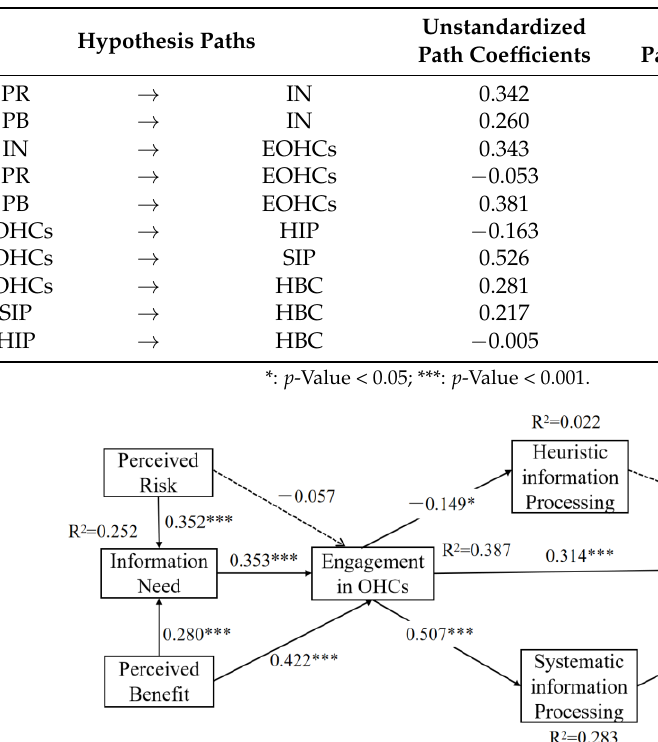
Table 5. Hypothesis testing results of the research model.